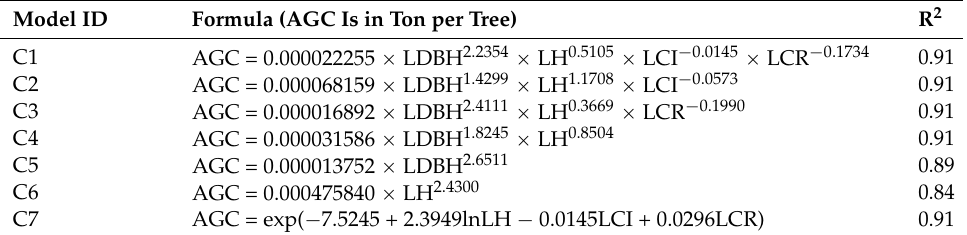
Table 1. Biomass-based tree-level AGC models using LiDAR-derived tree metrics.